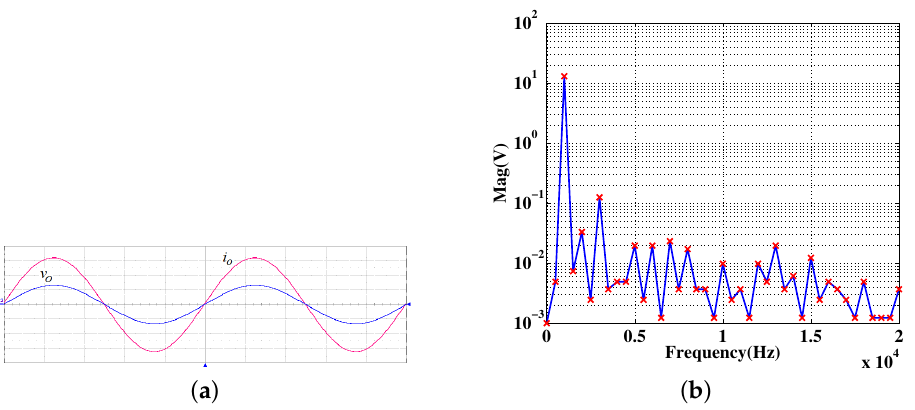
Figure 19. ( a ) v o , i o waveform for 20 W load: v o (10 volt/div), i o (1 amp/div), timescale: (200 mi- crosecond/div). ( b ) Frequency spectrum of output voltage v o at 20 W.